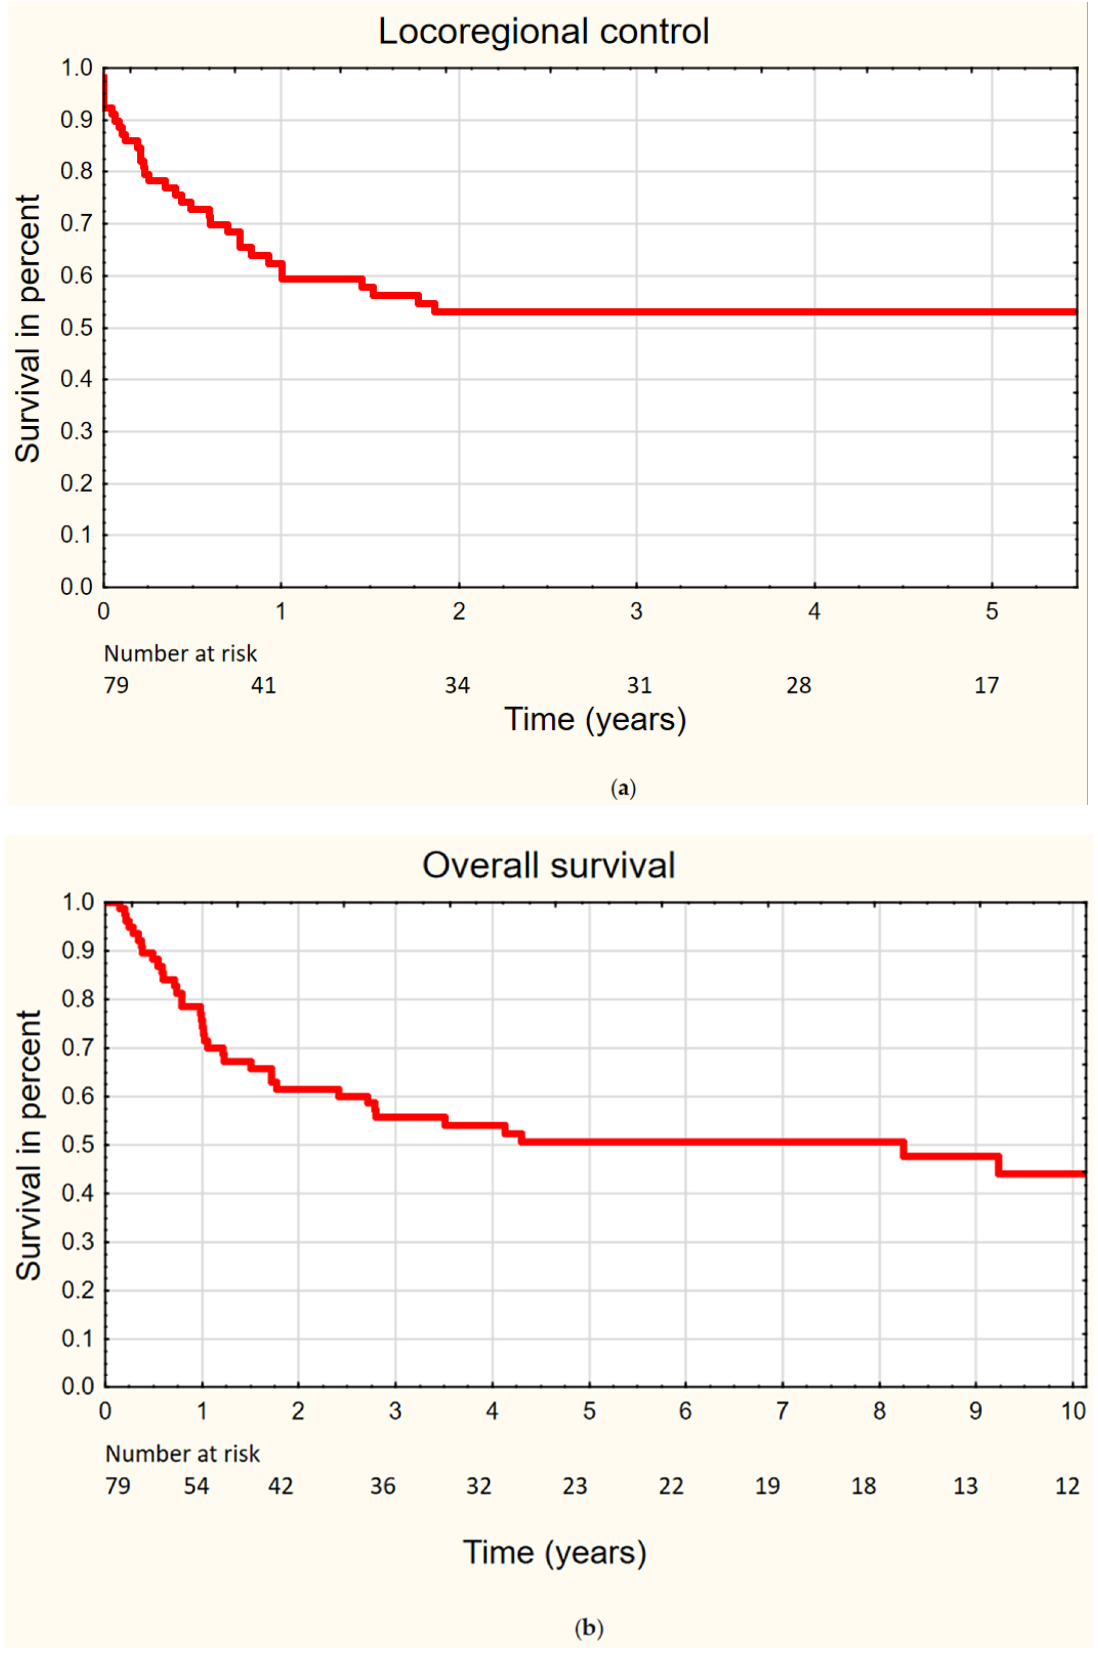
Figure 1. ( a ) Locoregional disease-free survival, ( b ) overall survival.